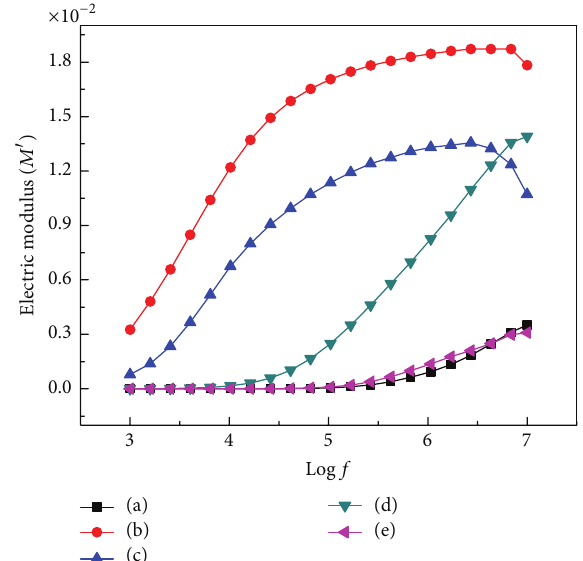
Figure 6: Variation of dissipation factor as a function of AC frequency for (a) 1wt% Ppy/TiO 2 , (b) 2 wt% Ppy/TiO 2 , (c) 3wt% Ppy/TiO 2 , (d) 4 wt% Ppy/TiO 2 , and (e) 5 wt% Ppy/TiO 2 composites.